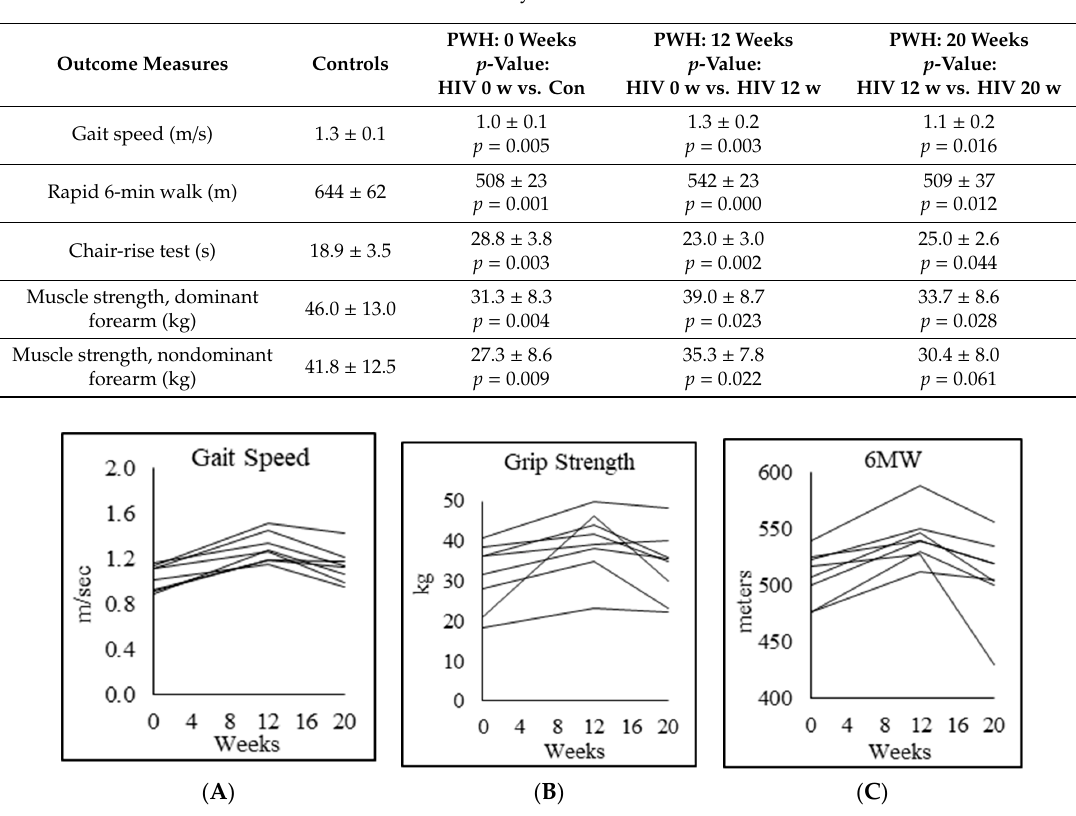
Figure 5. Individual participant data showing ( A ) gait speed, ( B ) forearm grip strength (dominant), and ( C ) rapid 6-min walk test (6MW).